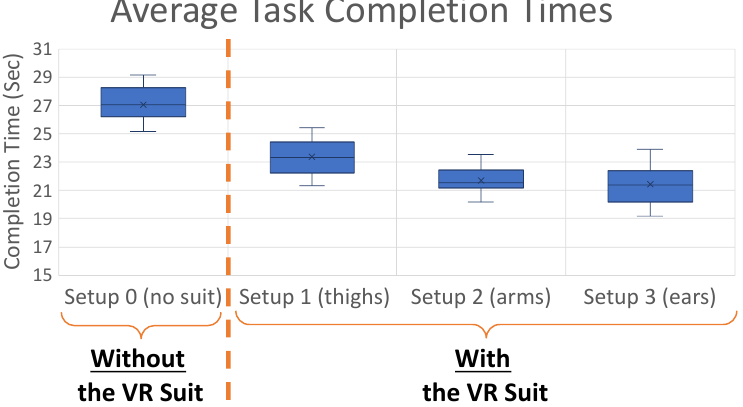
Figure 5. Average task completion times of each